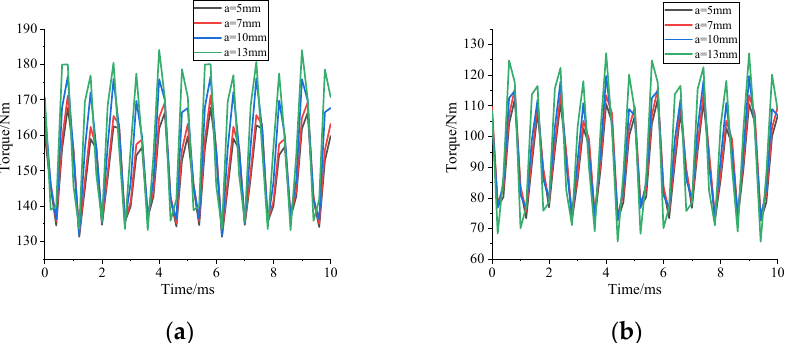
Figure 15. Motor output torque. ( a ) Output torque with the forward parallel permanent magnet; ( b ) output torque with the forward parallel permanent magnet.